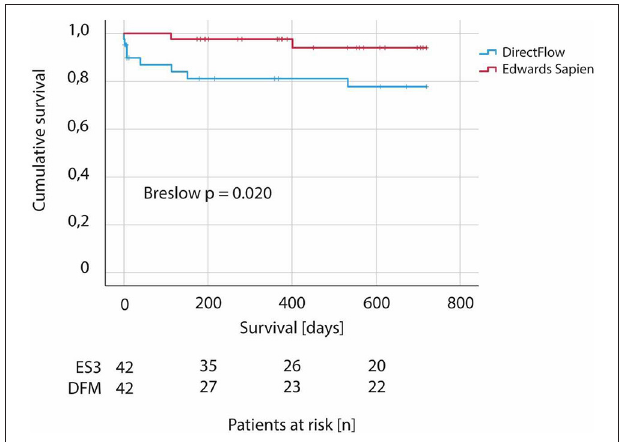
FIGURE 2 | Two-year survival in patients undergoing TAVI—comparison between DirectFlow and Edwards Sapien 3. Kaplan-Meier analysis according to type of valve (DirectFlow vs. Edwars Sapien 3). N = 84.